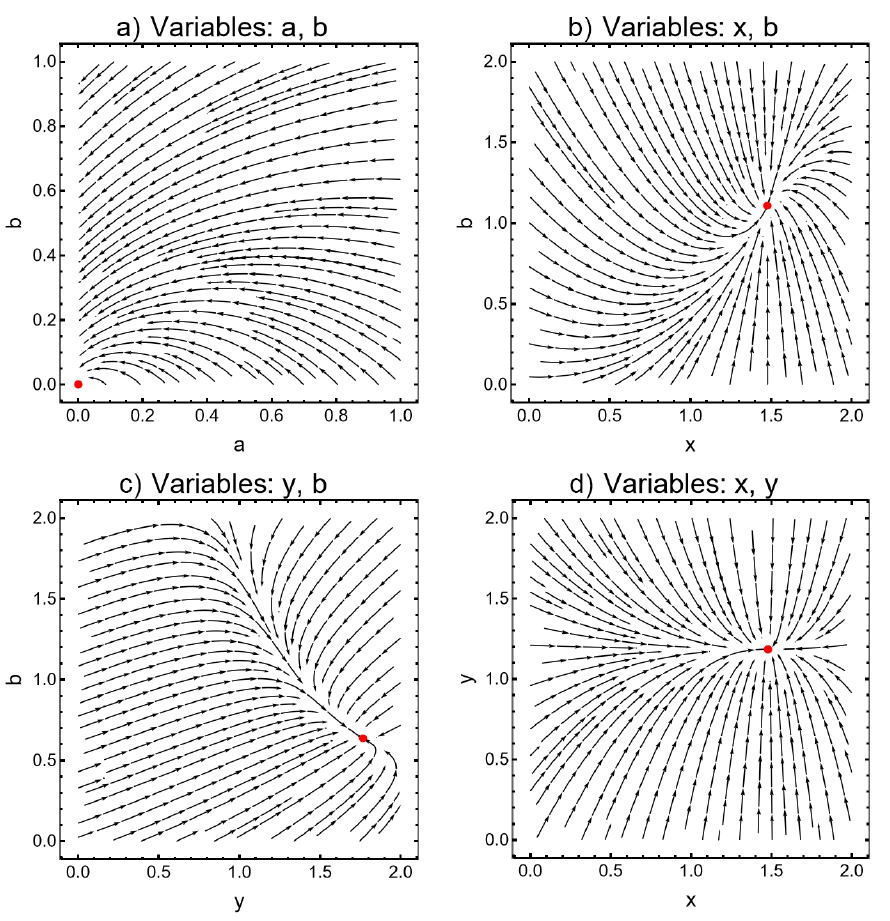
Figure 2. Directional fields for ( a ) RM2 and RM2s a , b variable (upper left), ( b ) x and b variable (upper right), ( c ) y , b variable in RM2 (lower left), and ( d ) x , y variable (lower right). All of the plots depict stable